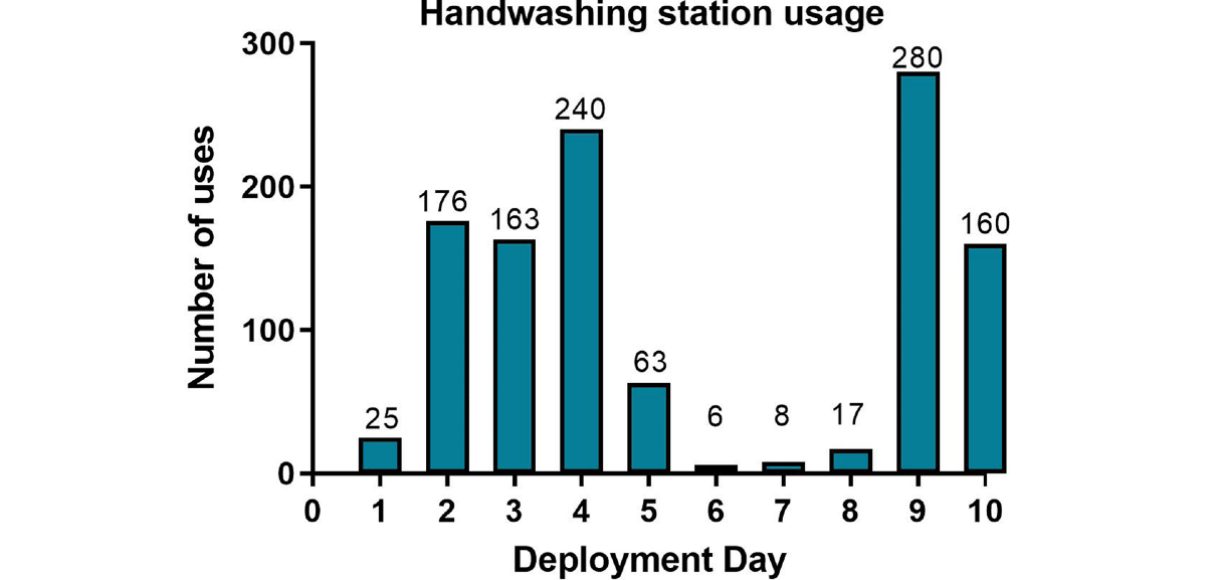
Figure 3. Field testing results of the smart handwashing station. The graph depicts the number of times the smart handwashing station was used each